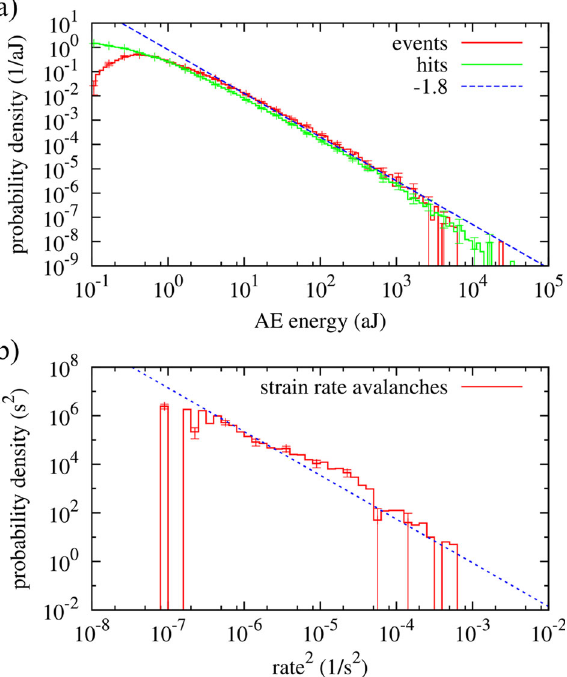
Fig. 5 Statistical properties of the phase-transformation avalanches on the plateau (log – log plots). a Probability density of AE avalanche energies. b Probability density of strain-avalanche magnitudes. In both panels the dashed blue line, drawn to guide the eye, indicates the behaviour of a power-law distribution with exponent